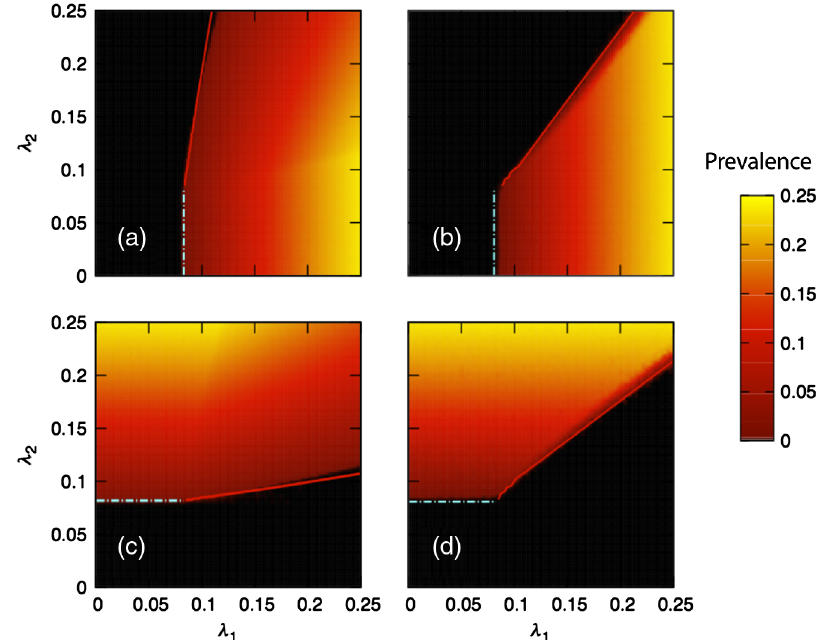
FIG. 6. Effect of degree correlations between the two scale-free networks on the steady prevalence levels. Dynamical parameters: μ μ 0 . 75 , β a β a 0 . The rest of the parameters are irrelevant, as no II individual will appear in the system. (a),(c) Final 1 ¼ 2 ¼ 1 ¼ 2 ¼ prevalence of diseases 1 and 2, respectively, for uncorrelated scale-free networks: P ð k; l Þ ¼ P ð k Þ P ð l Þ ¼ α k − γ l − γ . (b),(d) Final prevalence of diseases 1 and 2, respectively, for fully correlated scale-free networks: P ð k; l Þ ¼ αδ ð k − l Þ k − γ . In both cases, γ ¼ 2 . 5 .